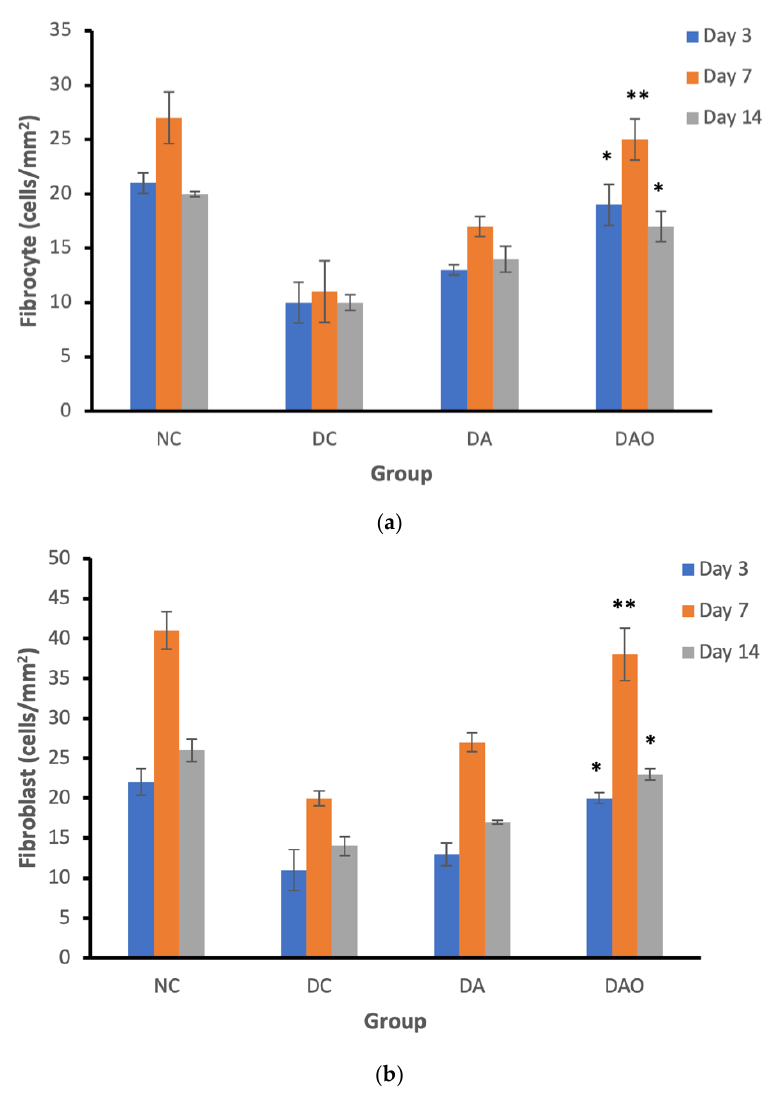
Figure 8. ( a ) Graph of the number of fibrocytes; ( b ) graph of the number of fibroblasts. Notation on the graph showed the result of the statistical test (α < 0.05). (*) and (**) notation shows insignificant differences with NC, but significant differences with DC. * = 0.01 ≤ α < 0.05; ** = α ≤ 0.01 .